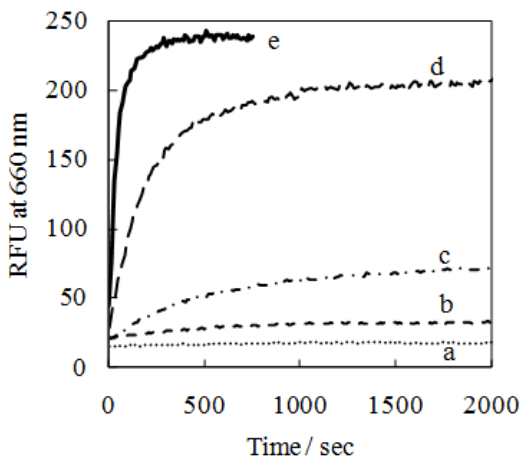
Figure 5. Time courses of emissive complexes of the dye ([SQ-BA] = 1  M), with excess fructose: ( a ) [fructose] = 0, ( b ) 50  M, ( c ) 0.5 mM, ( d ) 5 mM, and ( e ) 50 mM, prepared in carbonate buffer (10 mM, pH